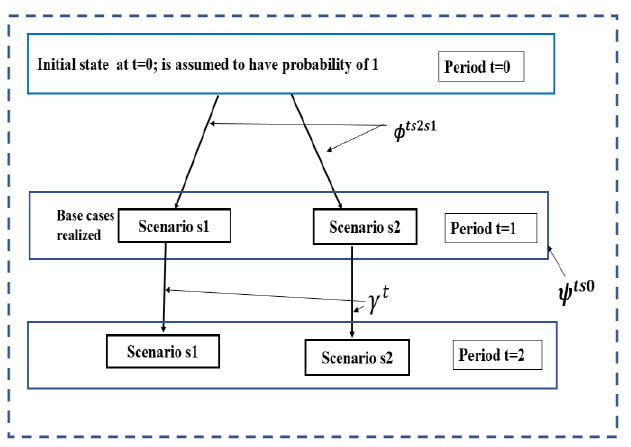
Figure 9. Probability transition states in the multiperiod stochastic economic dispatch problem.